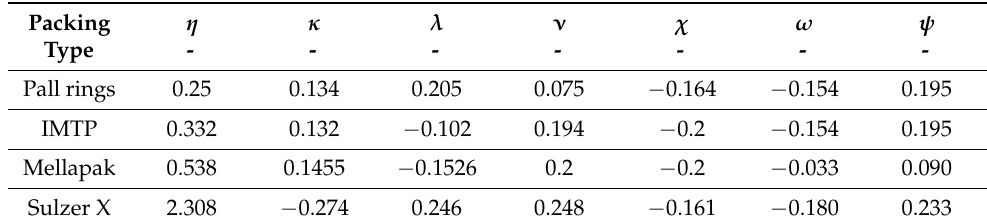
Table 8. Effective wet surface area characteristic parameter in the HC model for different metal packings